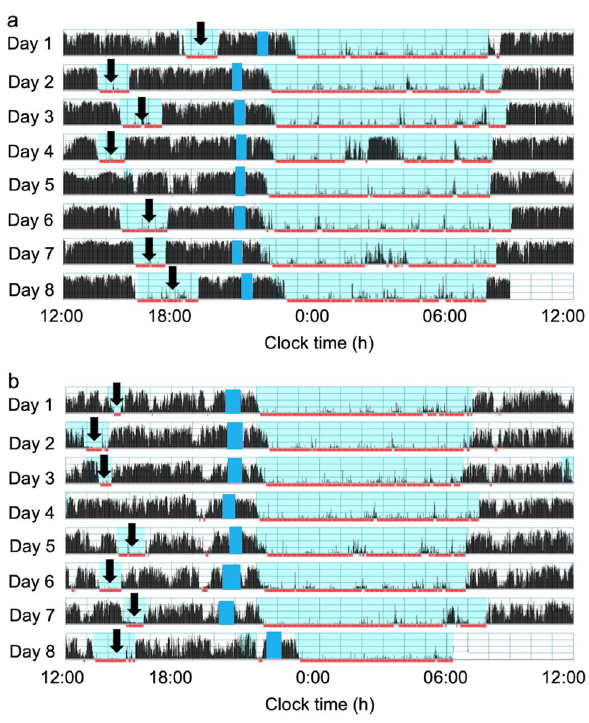
Figure 1. The representative actograms of both preterm ( a ) and term ( b ) toddlers of approximately 1.5 years of age. Figures ( a ) and ( b ) show the daytime activity and nighttime sleep patterns of two individuals chosen as typical examples to represent their corresponding groups. The vertical axis shows the 7 consecutive observation days and the horizontal axis shows the course of each 24 h day from 00:00 h (12:00 am) to 24:00 h (12:00 am). Activity counts per minute are represented by the height of the vertical black bars on each actogram. The arrows and the blue rectangles indicate naps and bathing periods, respectively. The red underlines are the periods that were automatically judged as sleep periods by the actigraph software. Note that, compared to the term toddlers ( b ), the preterm toddlers ( a ) had more nocturnal awakenings and daytime activity despite having almost no difference in sleep onset and wake